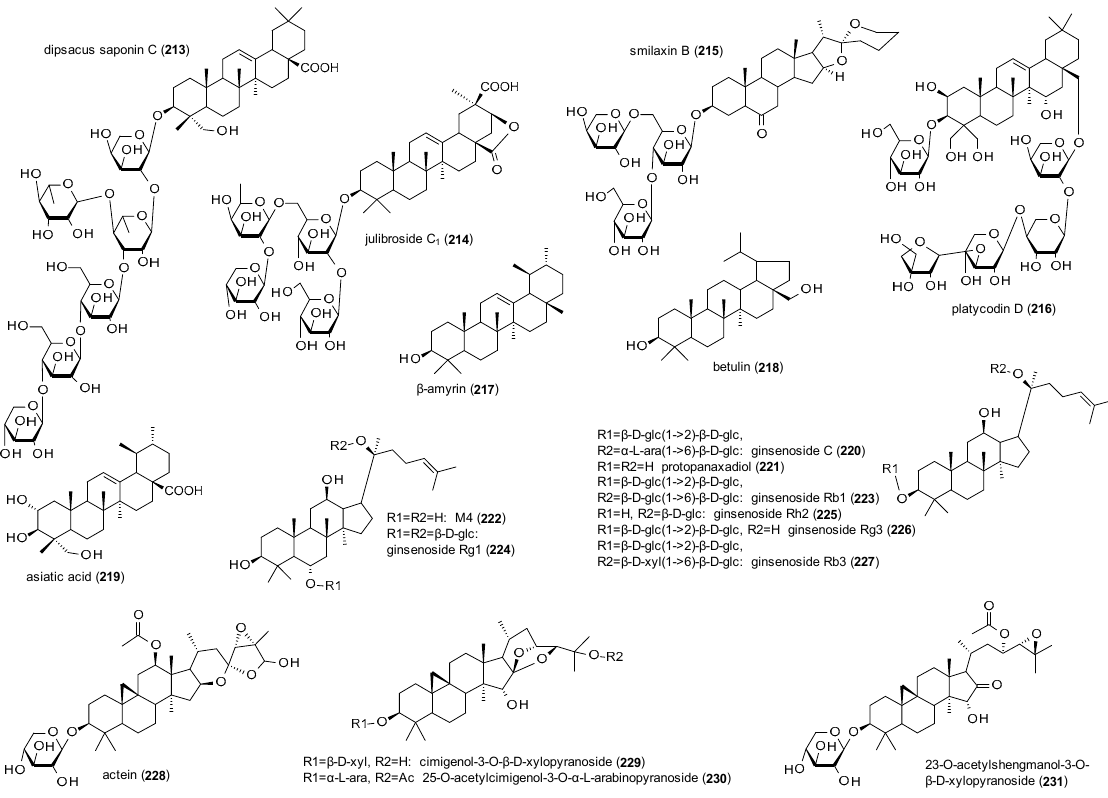
Figure 14. Chemical structures of triterpenes with reported GABA(A)-receptor modulating activity. Dipsacus saponin C ( 213 ), an oleanol-type triterpenoid isolated from Dipsacus asper , showed inhibition of tail-flick responses after intrathecal administration of 3.75 to 30 µ g of the compound [155]. Pretreatment with 5-aminovaleric (1 to 20 µ g i.c.v.) and gabazine (0.1 to 2 ng i.c.v.) both attenuated